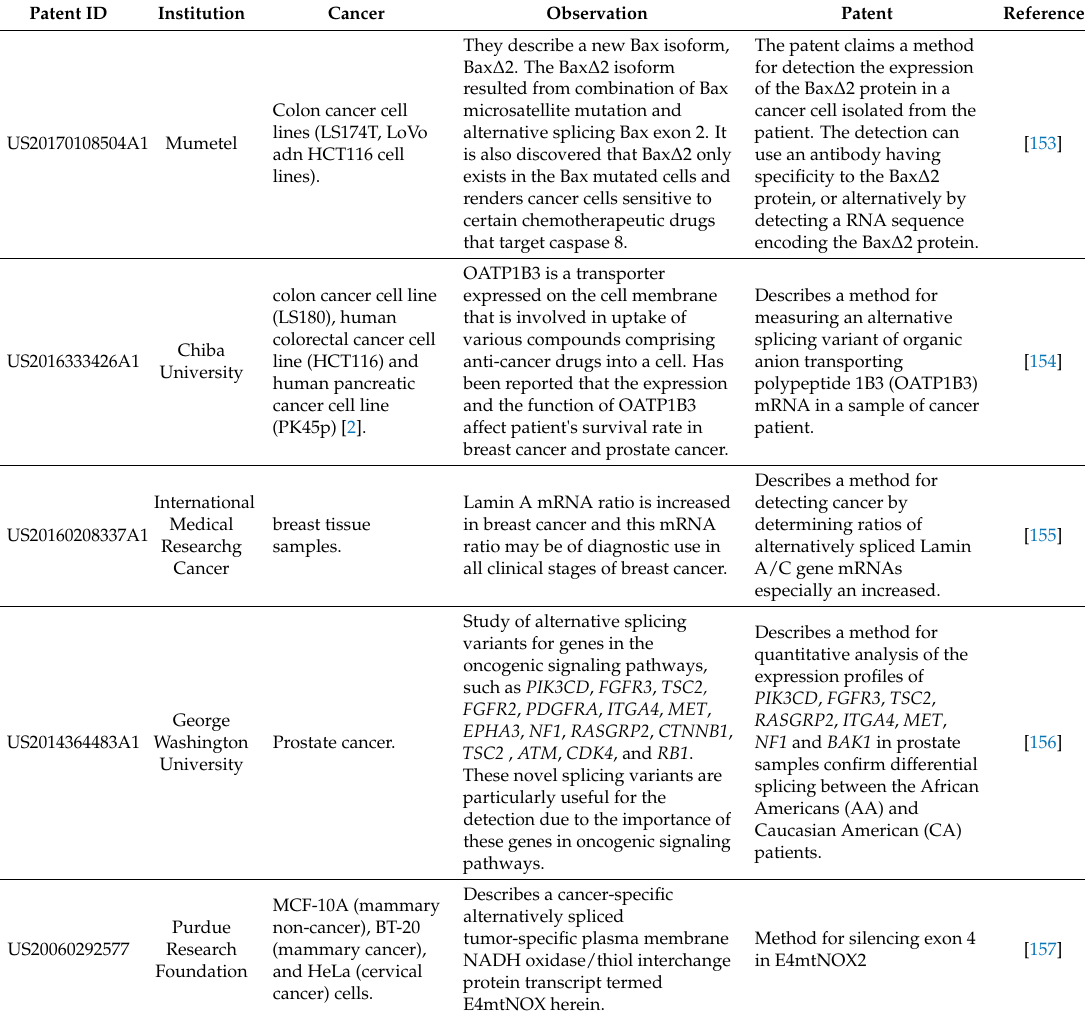
Table 3. Current patents in alternative splicing and